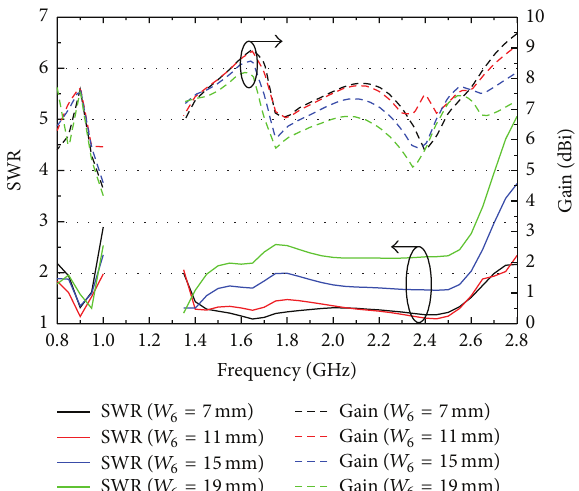
Figure 9: Effects of the